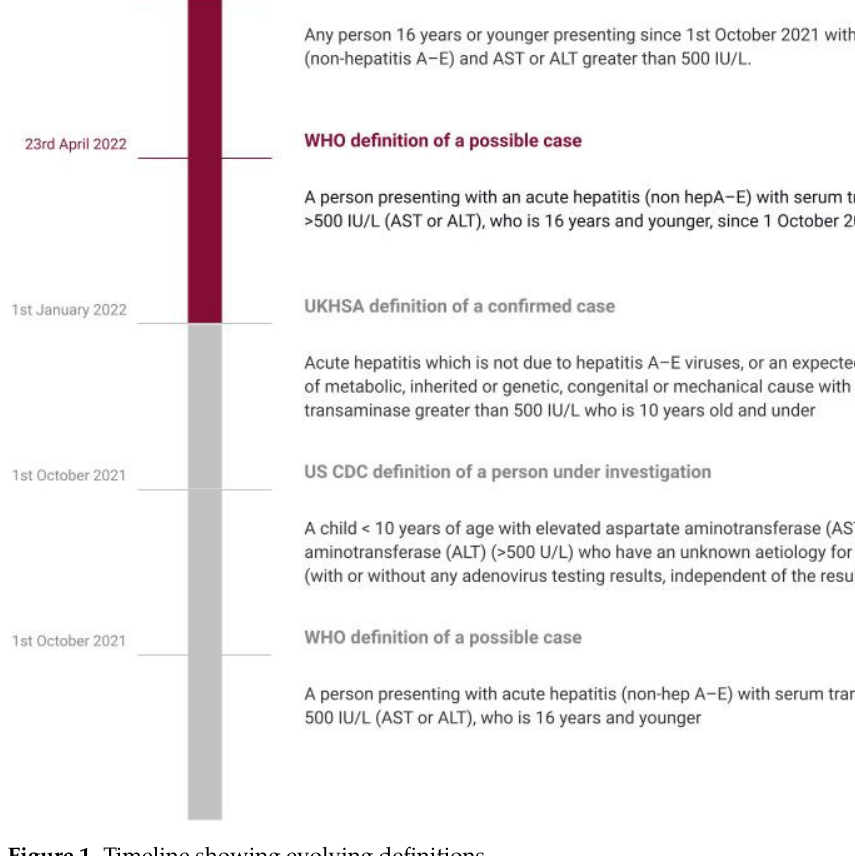
Figure 1. Timeline showing evolving definitions.